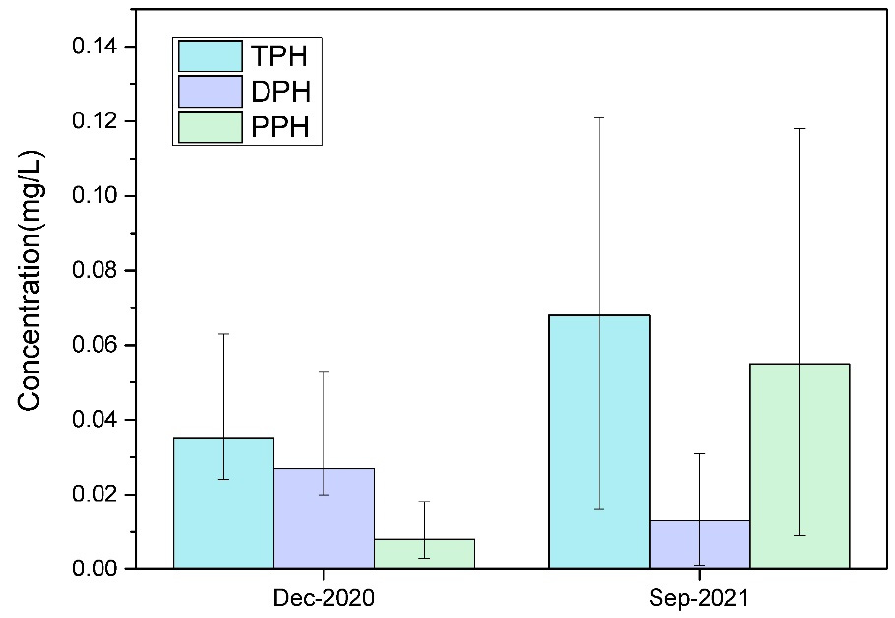
Figure 6. Concentration of different PH components in Dalian coastal waters. Bars represent the mean concentration and error bars represent the maximum and minimum of the data from each survey.